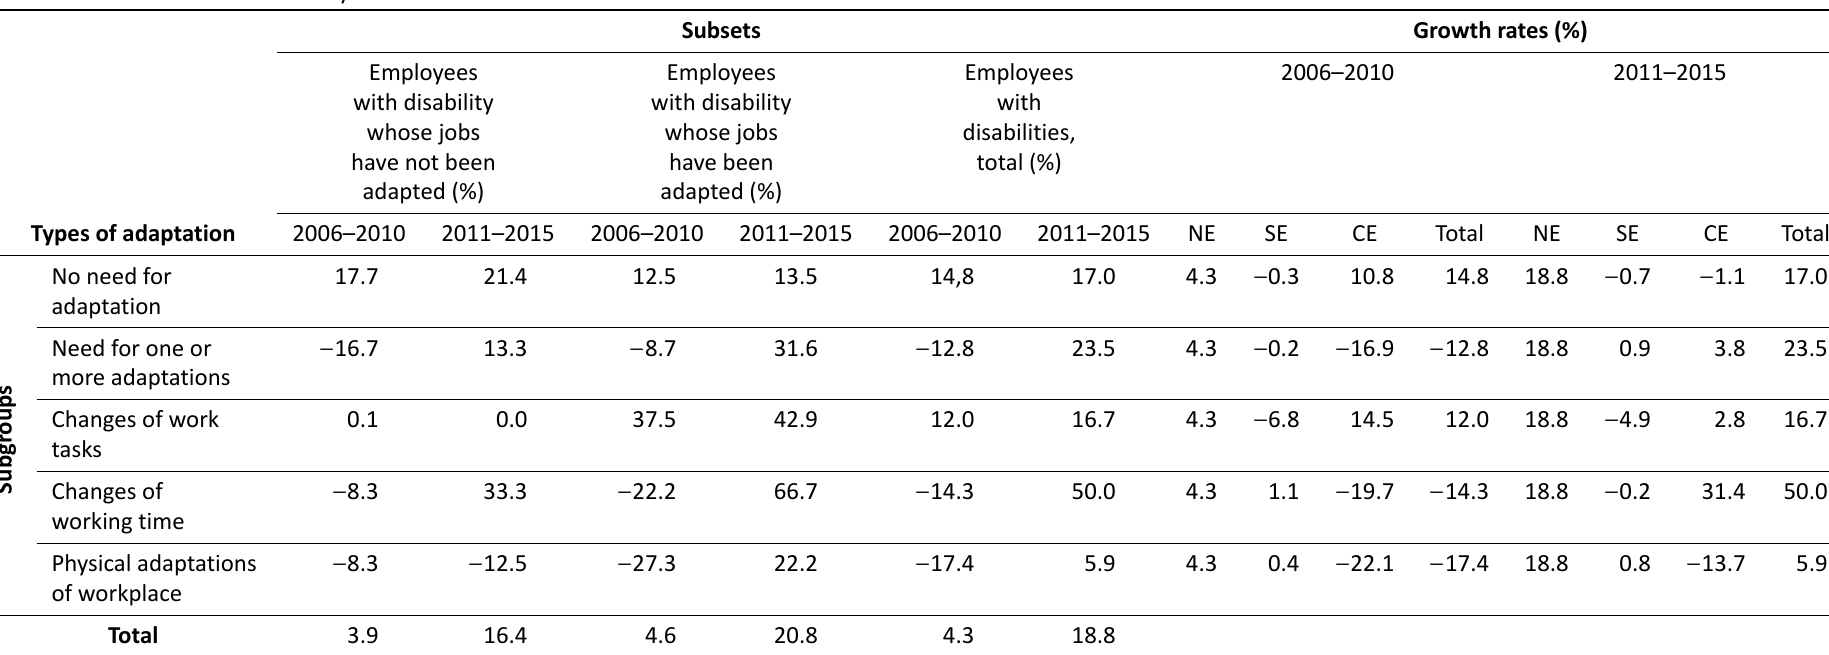
Table 1. Results of shift-share analysis.